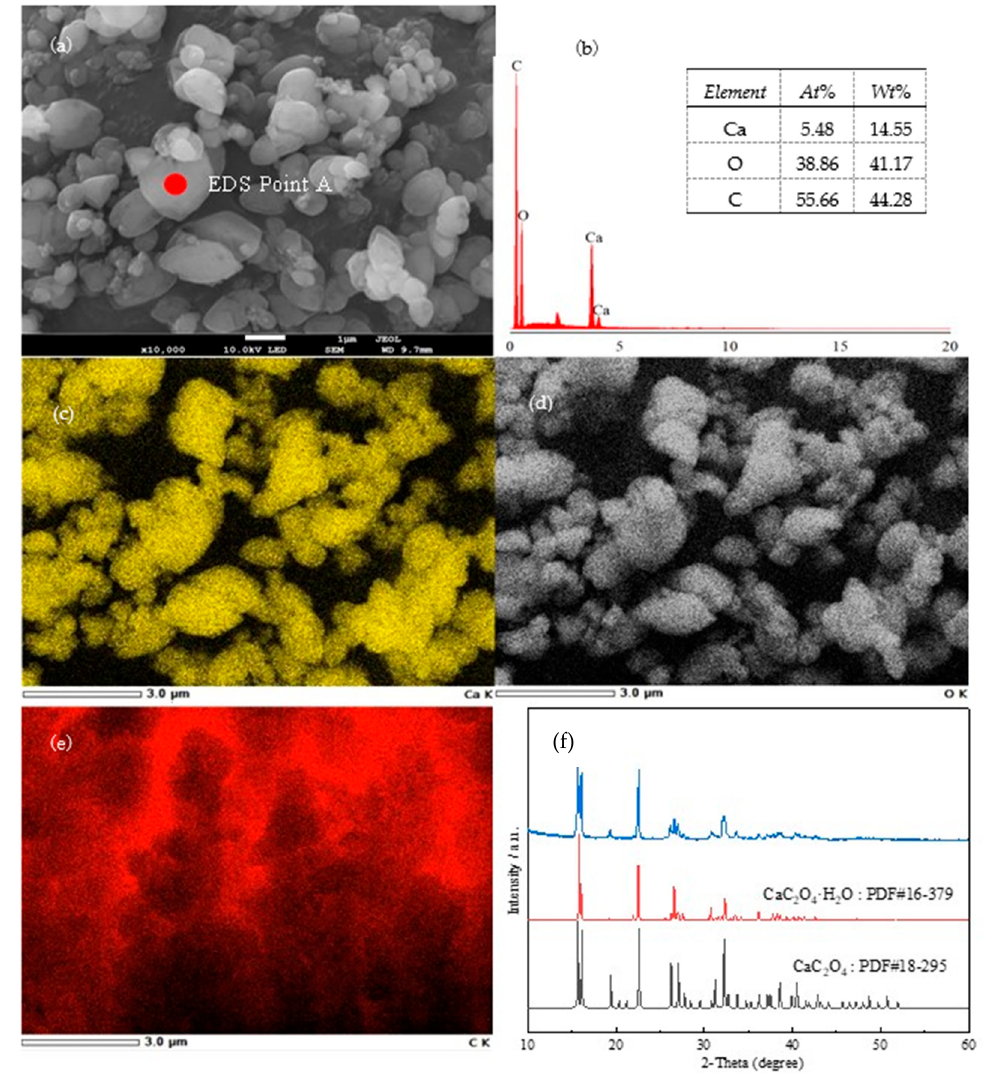
Figure 7. Characterization of the product calcium oxalate: ( a ) SEM of calcium oxalate, ( b ) calcium oxalate A point EDS analysis, ( c ) calcium element distribution in calcium oxalate, ( d ) oxygen element distribution in calcium oxalate, ( e ) carbon element distribution in calcium oxalate, and ( f ) XRD of the final calcium oxalate obtained under corresponding conditions (The conditions are: 200 r · min − 1 , 70 °C, 1.5 h, n (H 2 C 2 O 4 ): n (Ca 2+ ) = 1.2:1, n (NaOH): n (theoretically generated HCl) = 0.7:1).